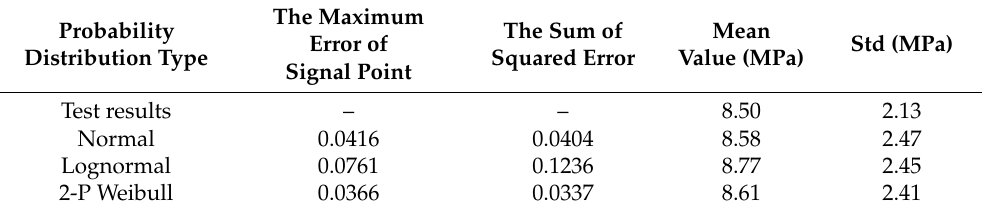
Table 1. Fitting results of short-term strength perpendicular to grain.